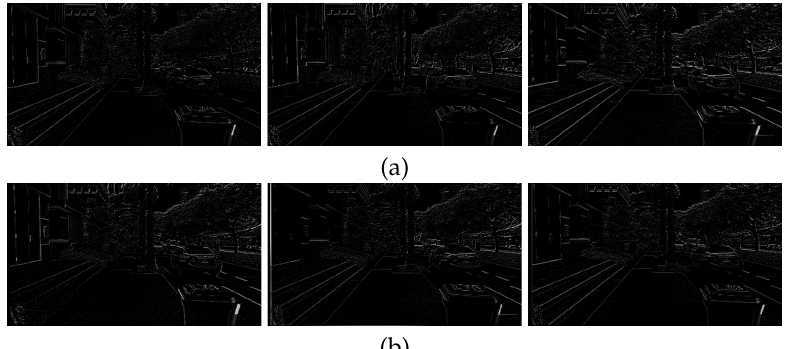
Figure 12. Experimental results of the video stabilization method: ( a ) differences of the original video (170th, 171st, and 172nd frames) and ( b ) the stabilized video (170th, 171st, and 172nd